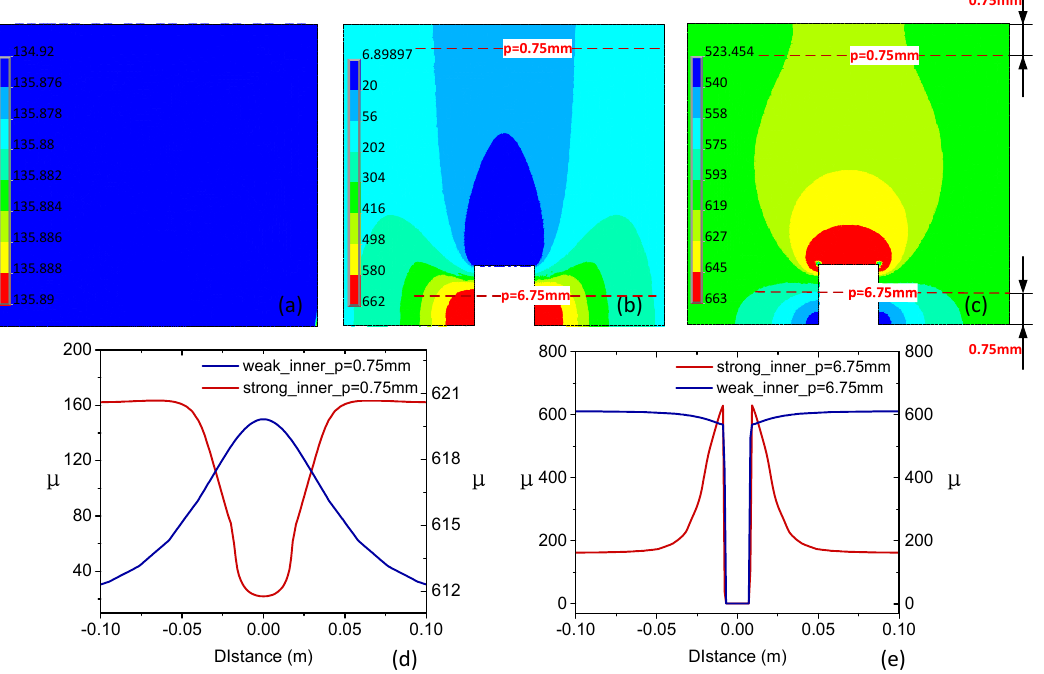
Figure 9. Relative permeability distribution obtained by simulations. ( a – c ) show the magnetic per- meability distribution under no-defect, strong magnetization, and weak magnetization, respectively. ( d , e ) represent the permeability change curves of the path p = 0.75 mm and the path p = 6.75 mm. The weak magnetization corresponds to the rising phase (C) of the magnetization curve in Figure 5 and the strong magnetization corresponds to the decreasing phase (D) of the magnetization curve in Figure 5. The corresponding current densities